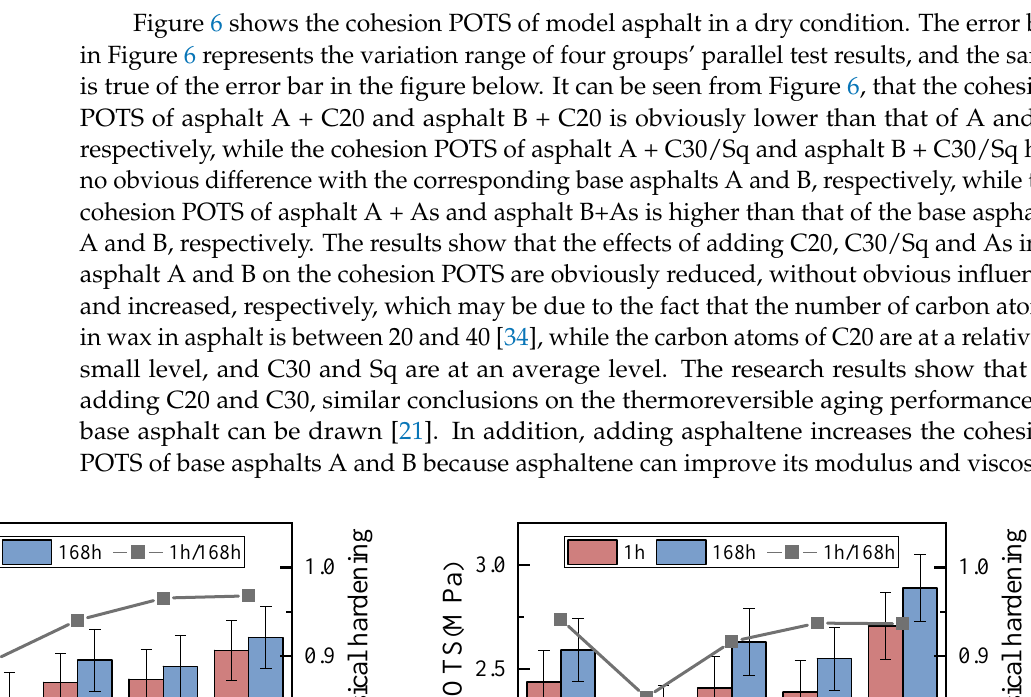
( b ) Figure 7. Adhesion POTS in wet conditions. ( a ) Asphalt A. ( b ) Asphalt B.